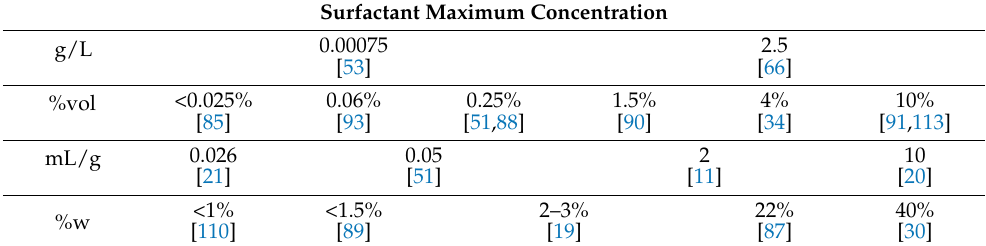
Table 8. Surfactant concentrations that were found in the references.